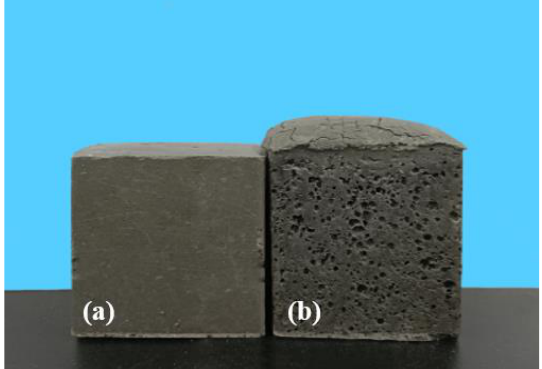
Figure 5. Comparison of cured bodies before ( b ) and after ( a ) fly ash treatment.